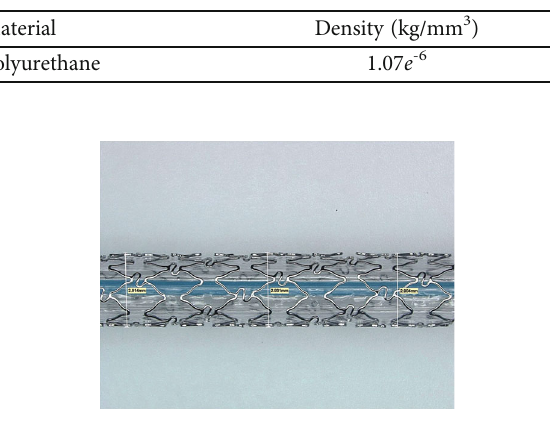
Figure 7: Expanded Osum